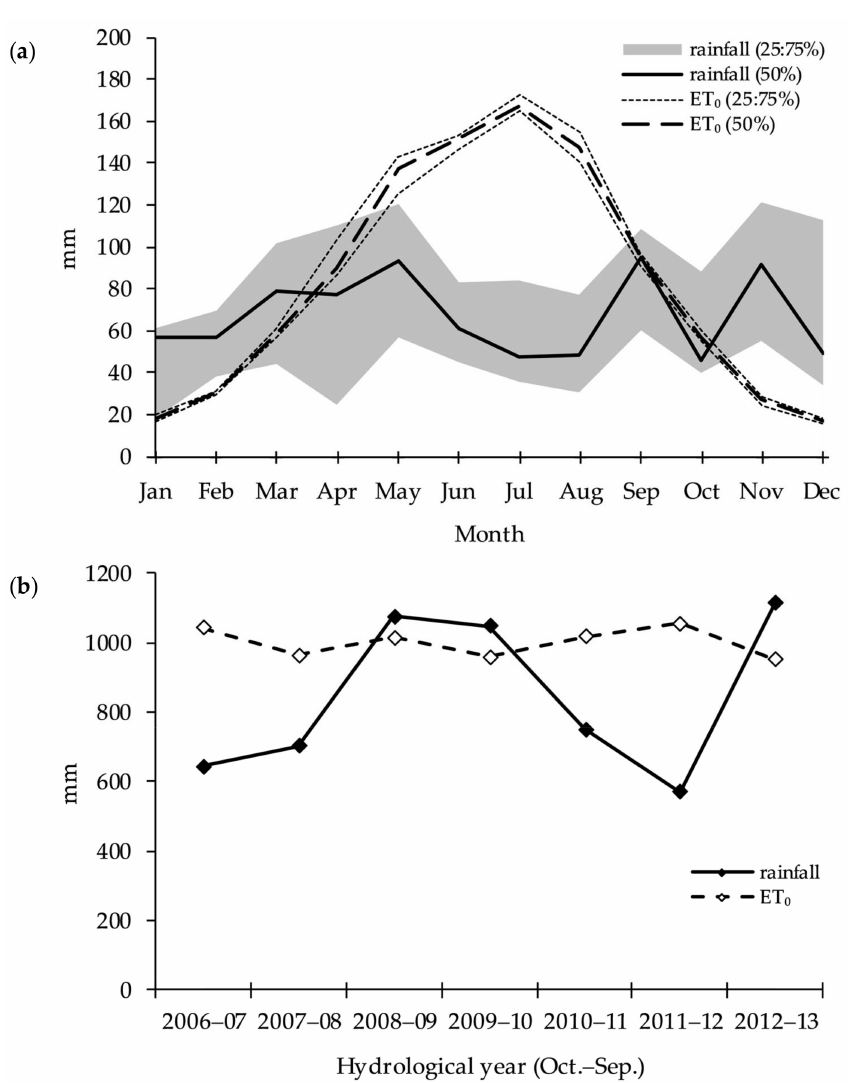
Figure 2. ( a ) Monthly rainfall and reference evapotranspiration (Hargreaves); median, 25th, and 75th percentiles are reported. ( b ) Annual rainfall and reference evapotranspiration; hydrological